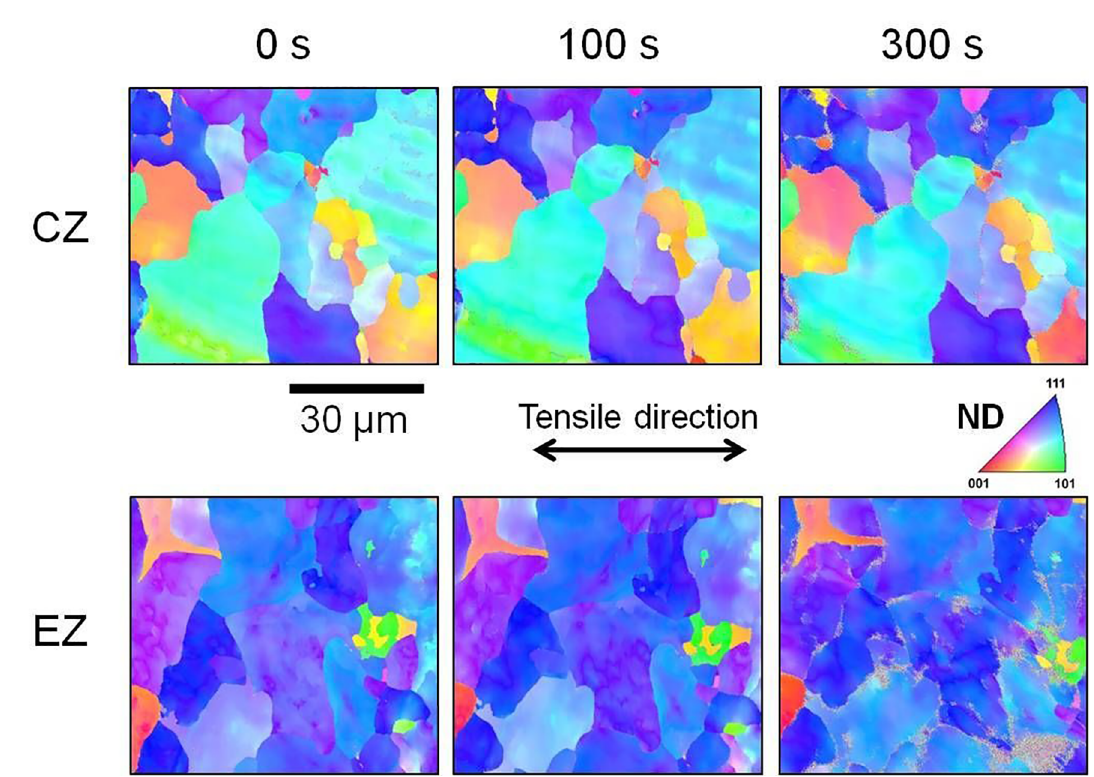
Figure 6. Inverse Pole Figure maps obtained from zones CZ and EZ after each test